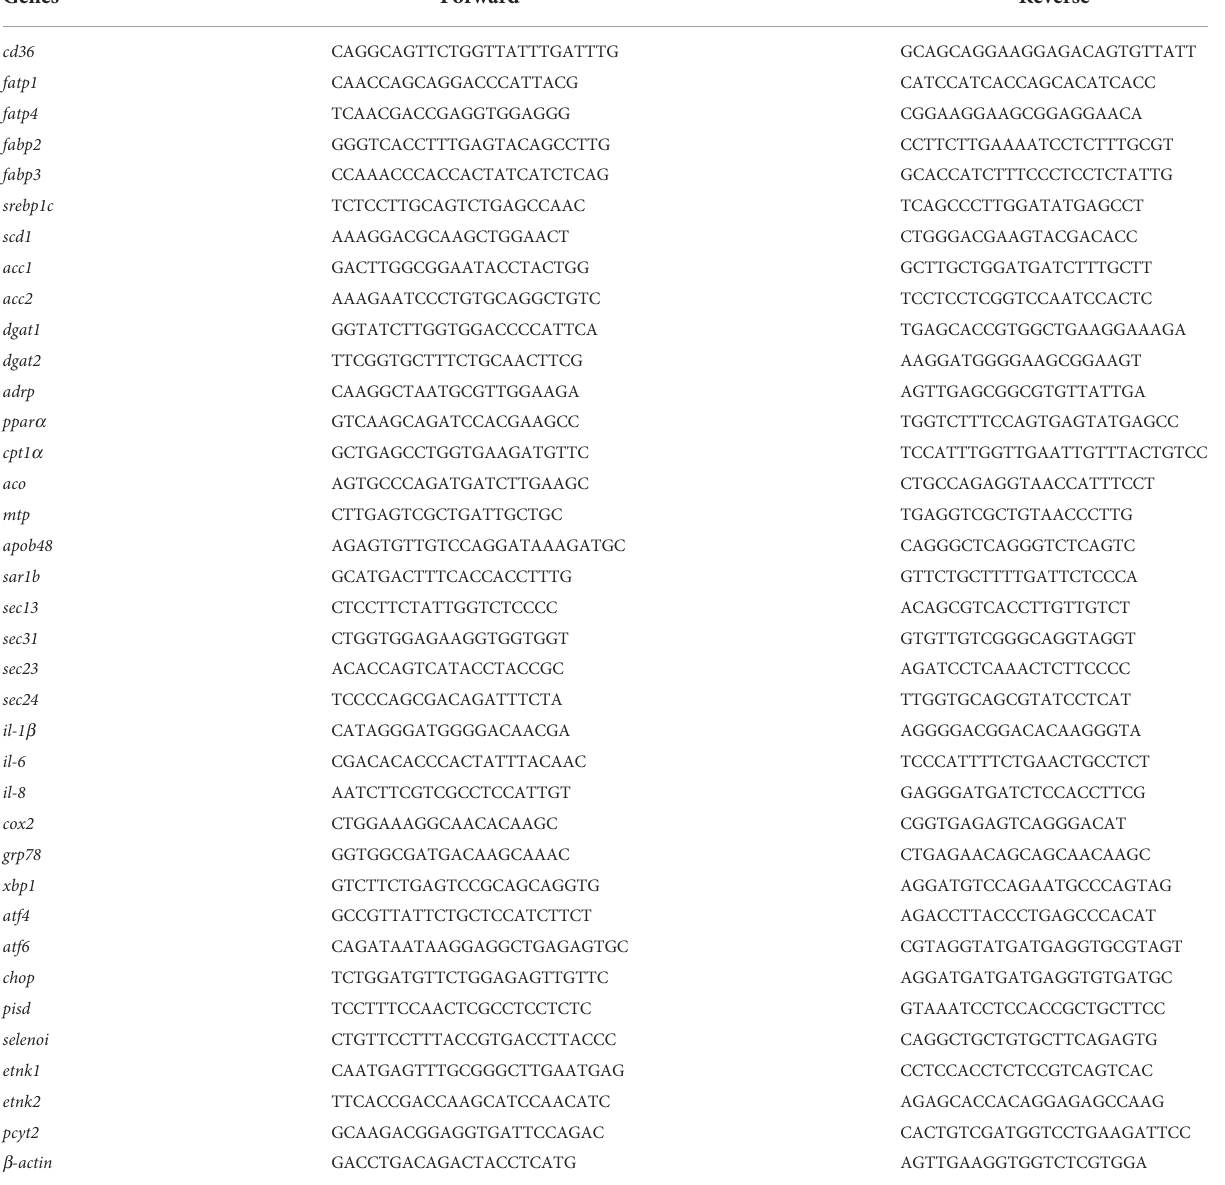
TABLE 2 Primer sequences used for quantitative real-time PCR in the study. Genes